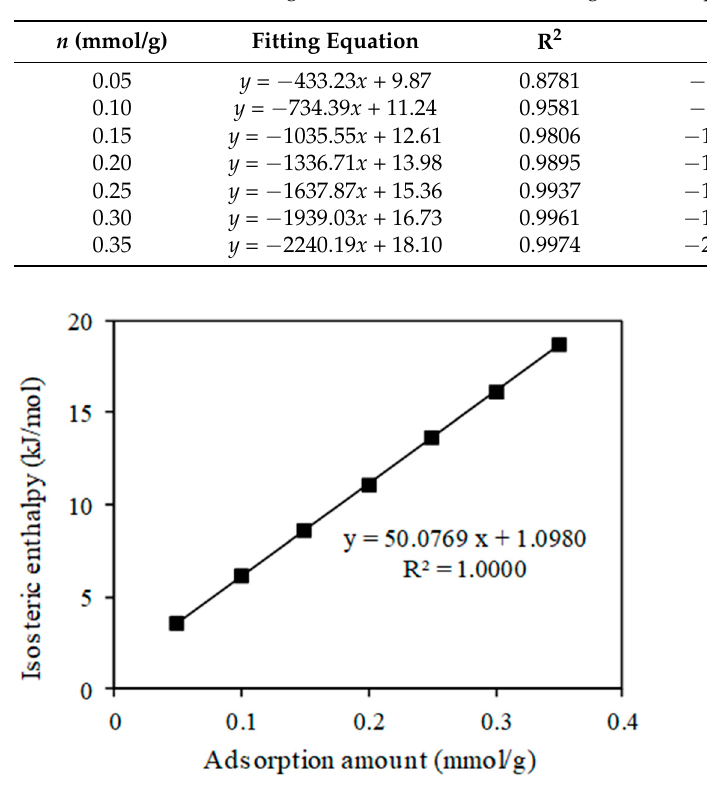
Figure 15. The relationship between isostatic enthalpy and adsorption amount.